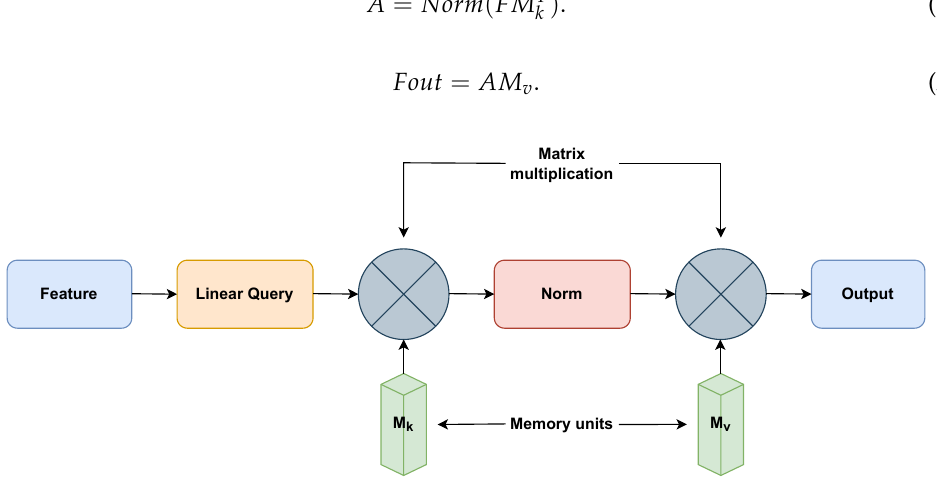
Figure 3. External-attention for EANet model